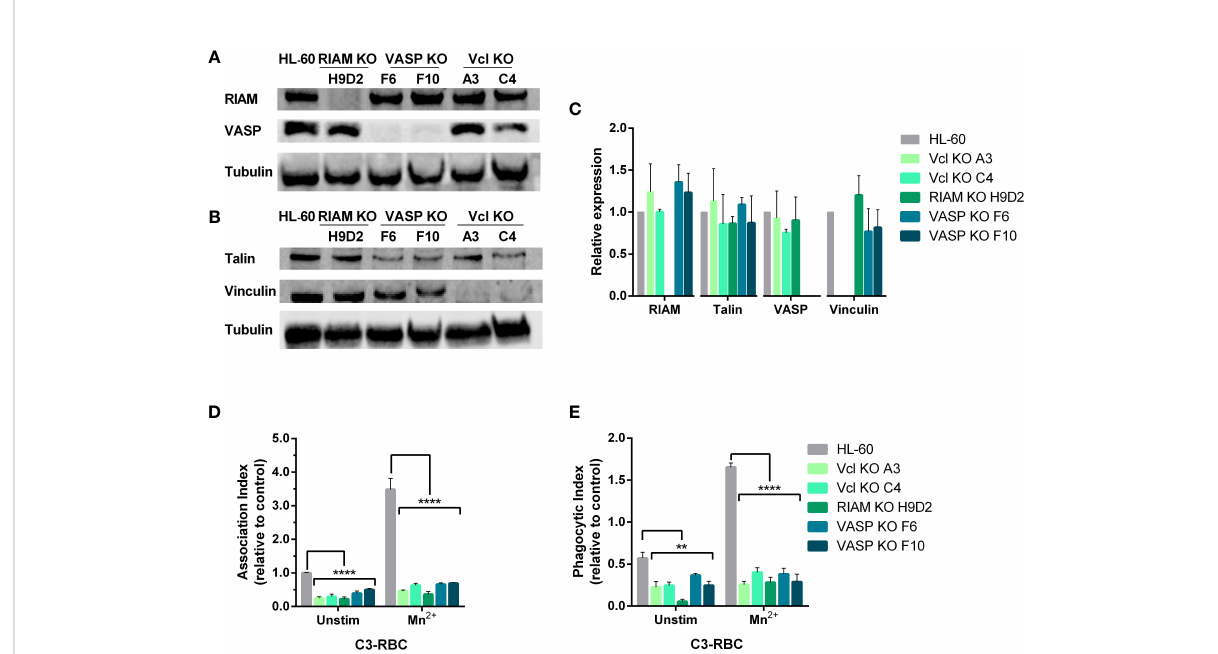
FIGURE 1 Knockout of either RIAM, VASP or Vinculin, abolishes phagocytosis. (A, B) Newly generated HL-60 Vinculin (Vcl), RIAM and VASP knockout monoclonal cell lines were tested for integrin related protein expression by western blot. (C) Quanti fi cation of protein expression in neutrophil- like HL-60 cells and derived knockouts analyzed by western blot. Results are represented as relative to HL-60 levels and are from 5 independent experiments. (D, E) Phagocytic cells were challenged with complement opsonized sheep red blood cells (C3-RBC) after being stimulated with 1 mM MnCl 2 or left unstimulated, and Association (AI) and Phagocytic (PI) indexes were obtained. Data are normalized with respect to the AI of unstimulated C3-RBC-challenged HL-60 cells (control cells). Data are presented as mean ± SD, where the error bars denote standard deviation. Signi fi cance (ANOVA) has been calculated with respect to HL-60 controls, ** denotes p<0.01 and